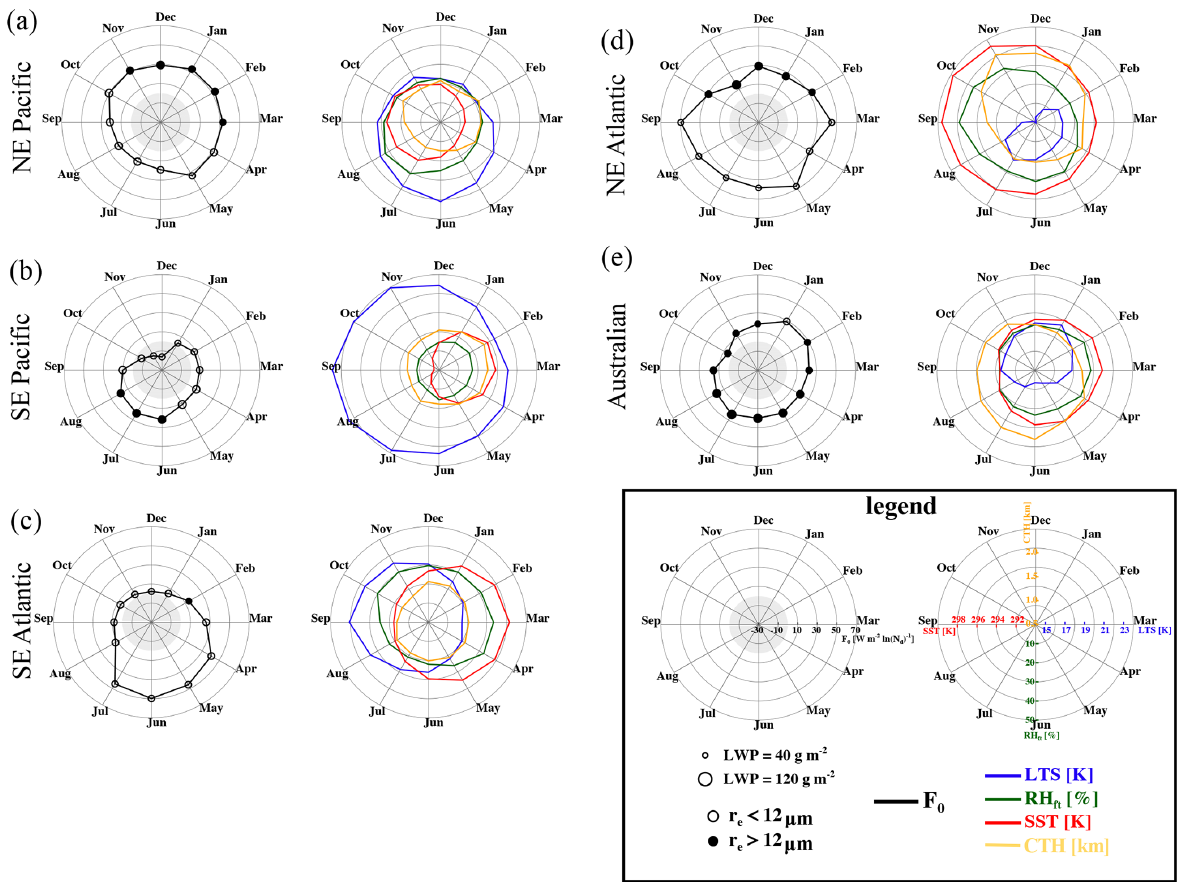
Figure 7. (Left plots of a–e ) Monthly mean radiative susceptibility ( F 0 ; black; positive values indicate cooling). The size of the circle indicates monthly mean LWP. Open (closed) circles indicate likely precipitating (non-precipitating) conditions based on r e = 12µm. (Right plots of a–e ) Monthly mean meteorological conditions: LTS (blue), RH ft (dark green), SST (red), and CTH (orange). Rows (a–e) represent results for the NE Pacific, SE Pacific, SE Atlantic, NE Atlantic, and the Australian stratocumulus regions,